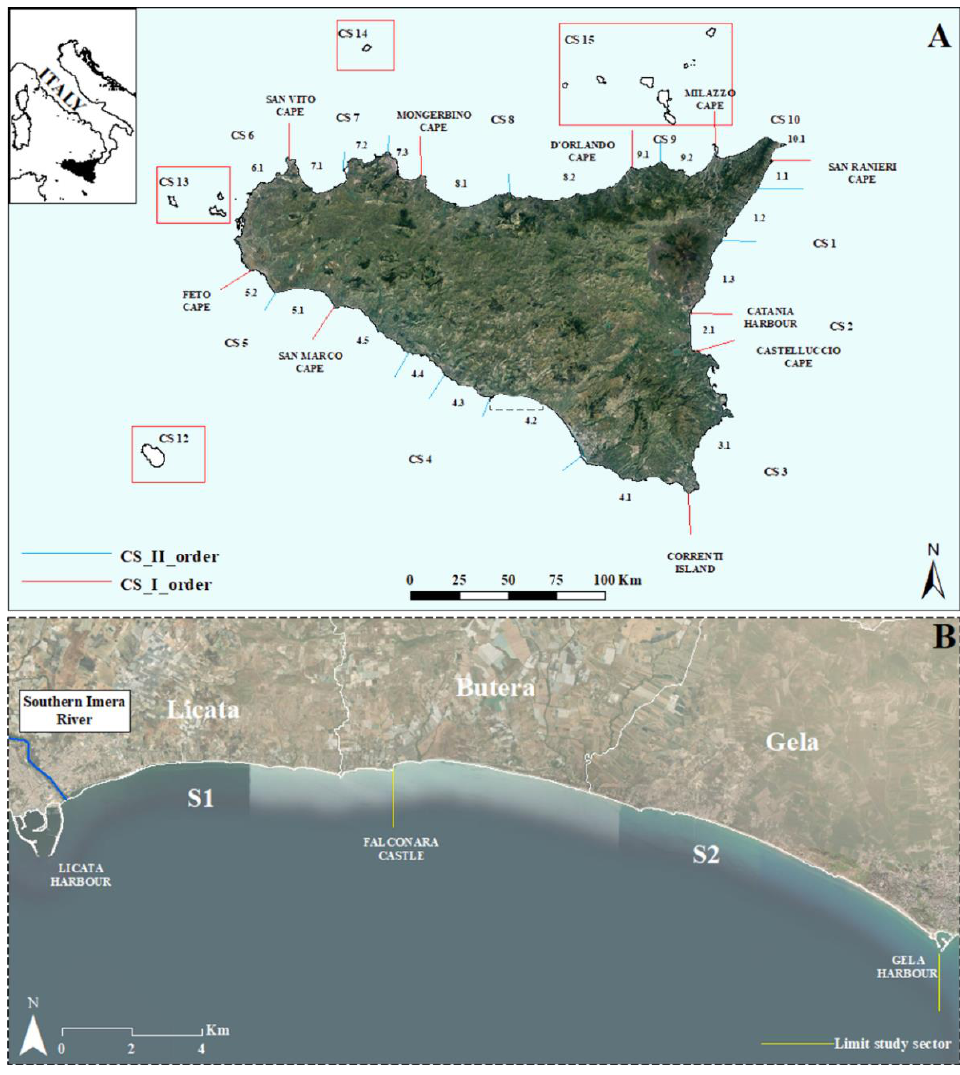
Figure 1. ( A ) The c oastal sub-cell subdivision of Sicily in I- and II-order cells [20]; ( B ) The study area and its subdivision into two sectors: sector no. 1, from the Licata harbour to the Falconara Castle, and sector no. 2, from the Falconara Castle to the Gela harbour.